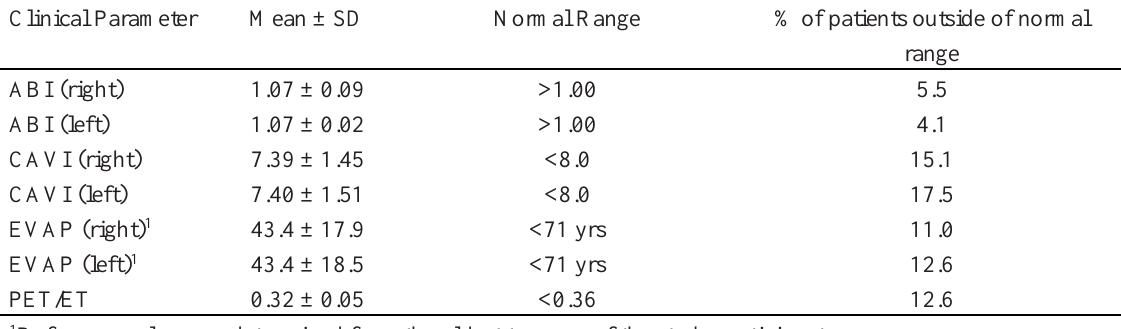
Table 3. Volumetric sphygmography vascular